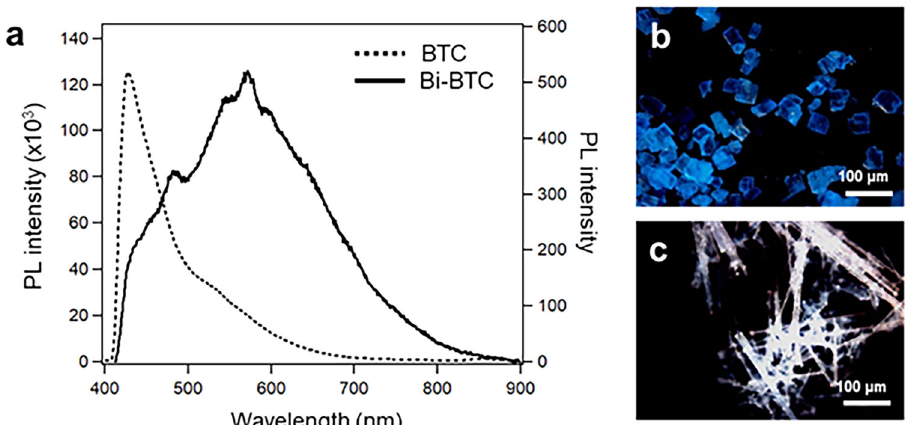
Fig. 4 Photophysical characterization of Bi-BTC. a Steady-state PL spectra of BTC (dotted line, left axis) and Bi-BTC crystal (solid line, right axis). b BTC and c Bi-BTC crystals image taken during exposure to a UV (365